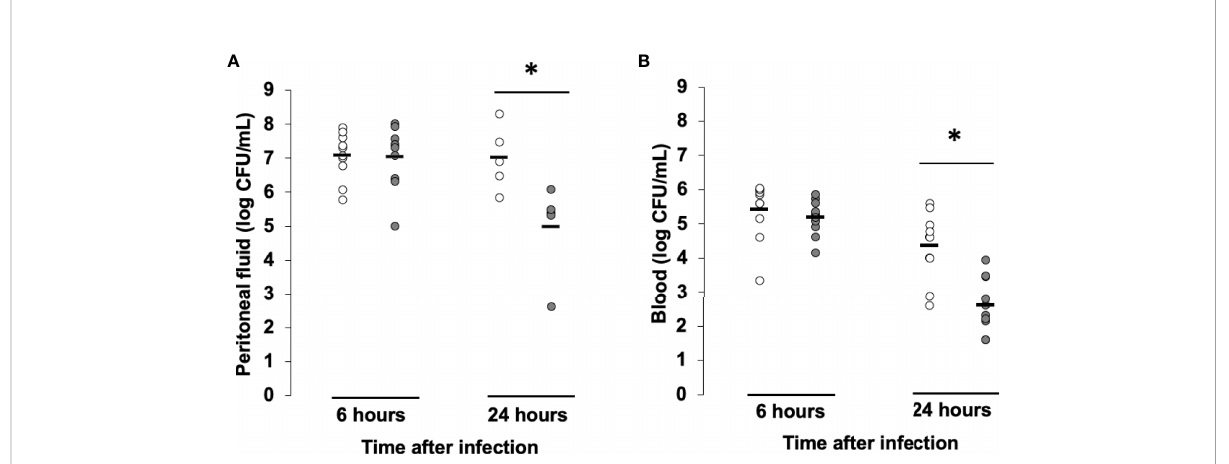
FIGURE 3 MMF improves bacterial clearance in mice infected with S. aureus . Mice were treated with MMF, which started one day before i.p. injection of 10 8 CFU S. aureus (n=10, grey dots) and were compared to control mice treated with an equivalent volume of NaCl 0.9% (control, n=10, white dots). 6 and 24 hours after infection, mice were euthanized and quantitative bacterial culture was assessed in peritoneal fl uid (A) and blood (B) . Differences between MMF and control conditions were calculated using Student ’ s t test. * P